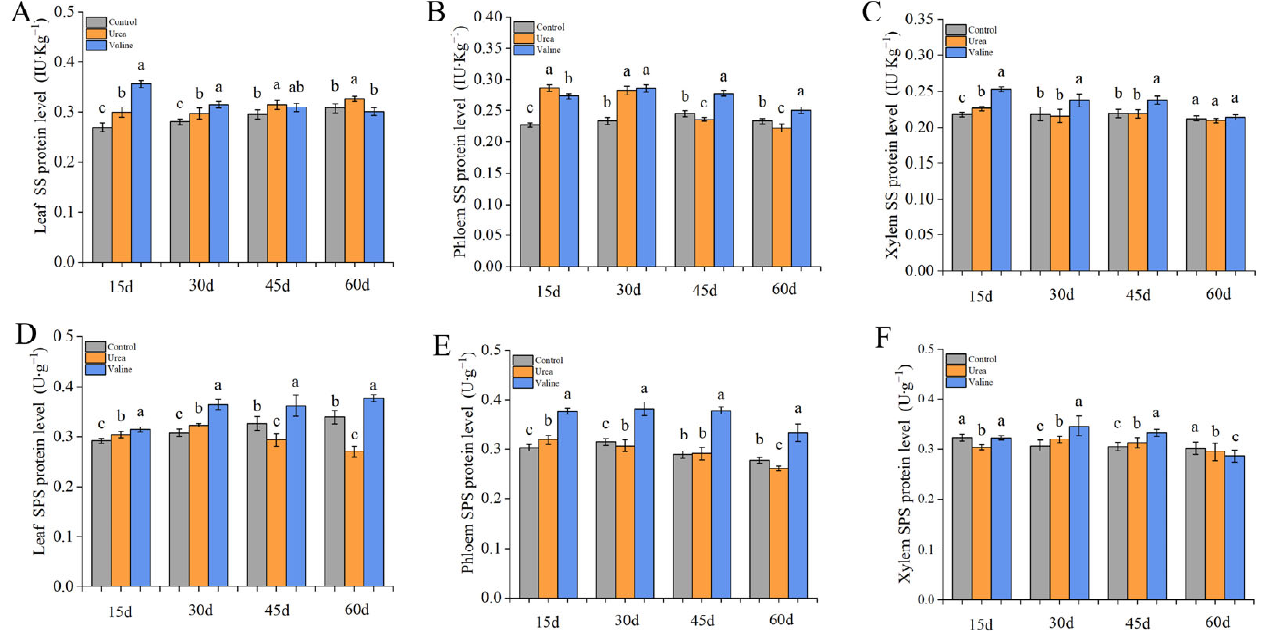
Figure 3. The effect of valine on carbon metabolism enzymes in peach tree. ( A ) Leaf SS protein level. ( B ) Phloem SS protein level. ( C ) Xylem SS protein level. ( D ) Leaf SPS protein level. ( E ) Phloem SPS protein level. ( F ) Xylem SPS protein level. The error bar represents the standard deviation of the mean ( n = 3). Different lowercase letters indicate significant differences among treatments (Duncan test, p < 0.05).